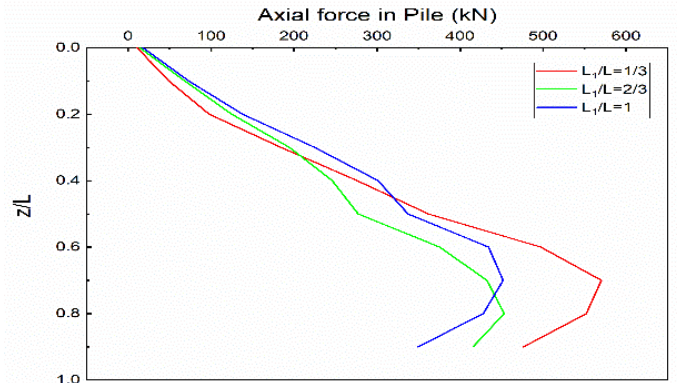
Figure 6. Axial force distribution in the friction pile caused by the driving of a nearby pile.